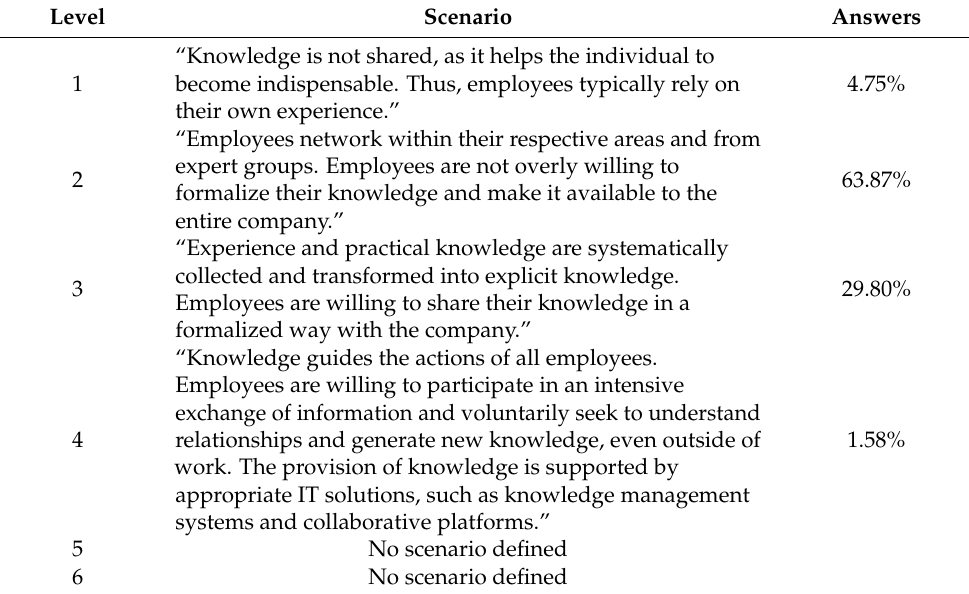
Table 7. Results for the capability “Knowledge and knowledge